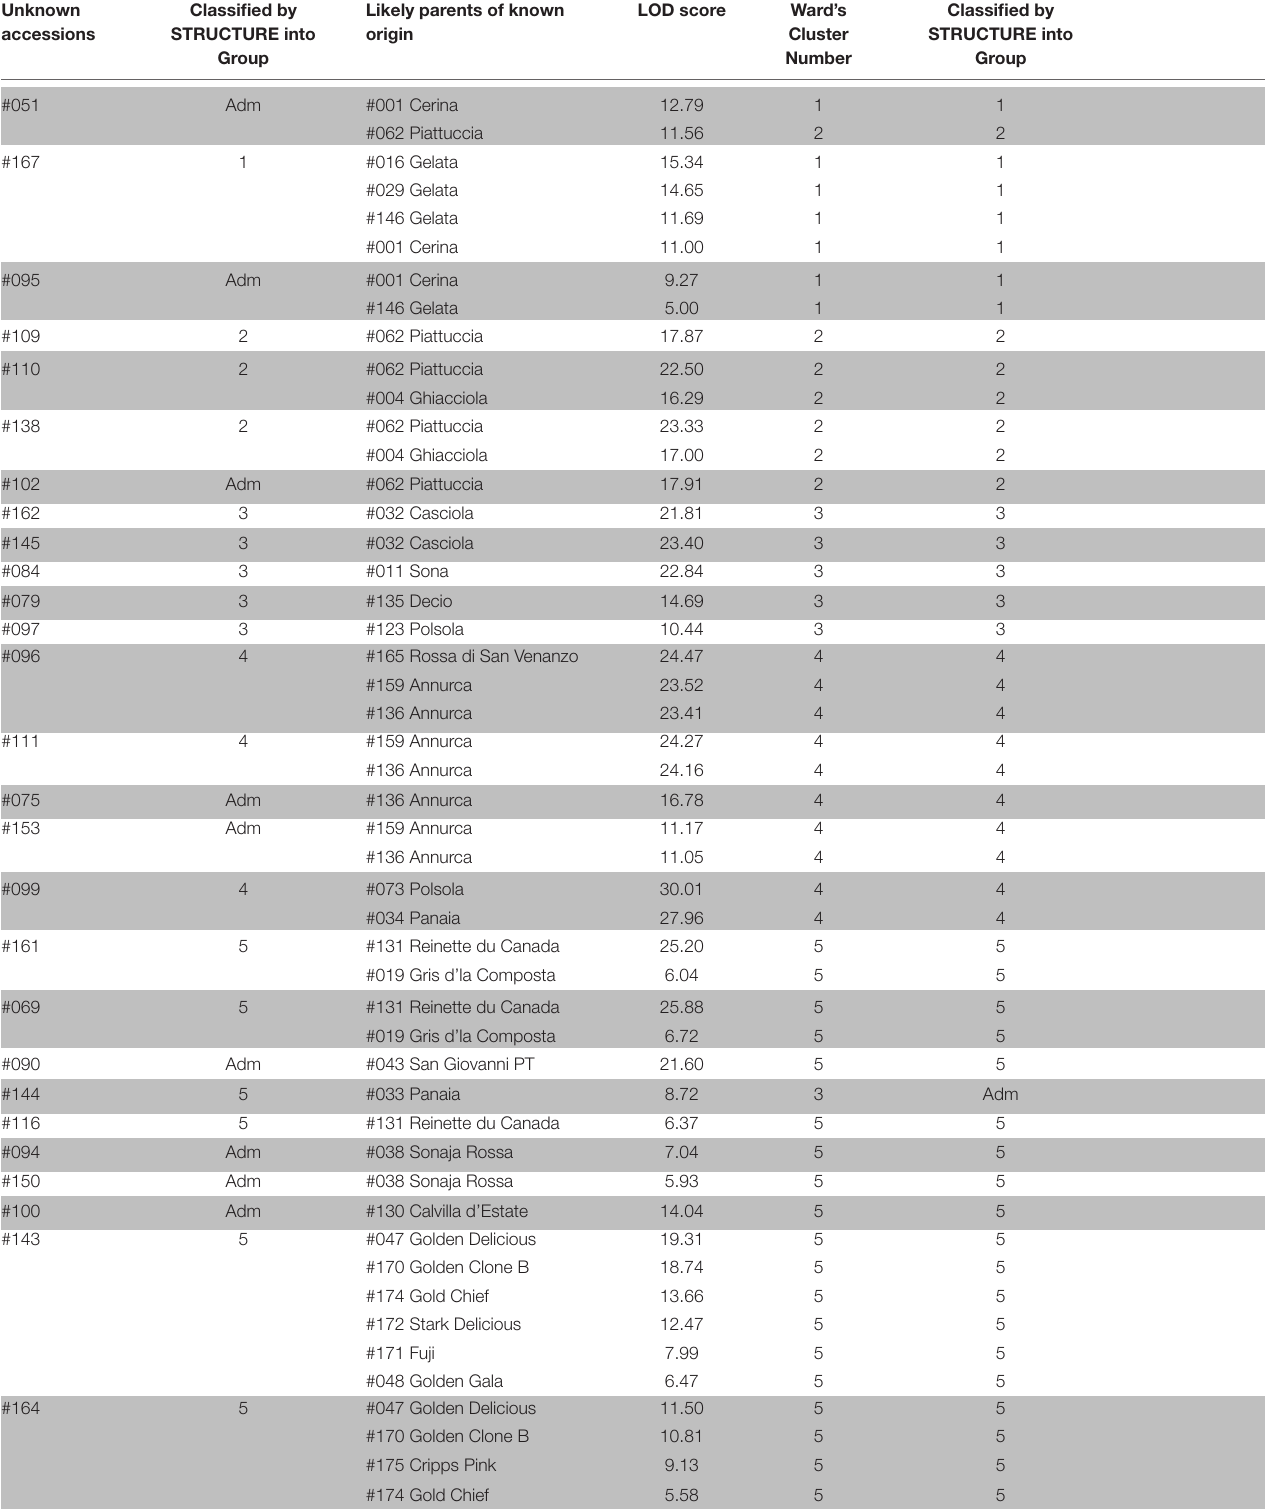
TABLE 7 | Parentage analysis of unknown accessions, their membership to the group of Stucture, the most likely parent of known origin (LOD score as otained by FaMoz) and its membership to Cluster and to